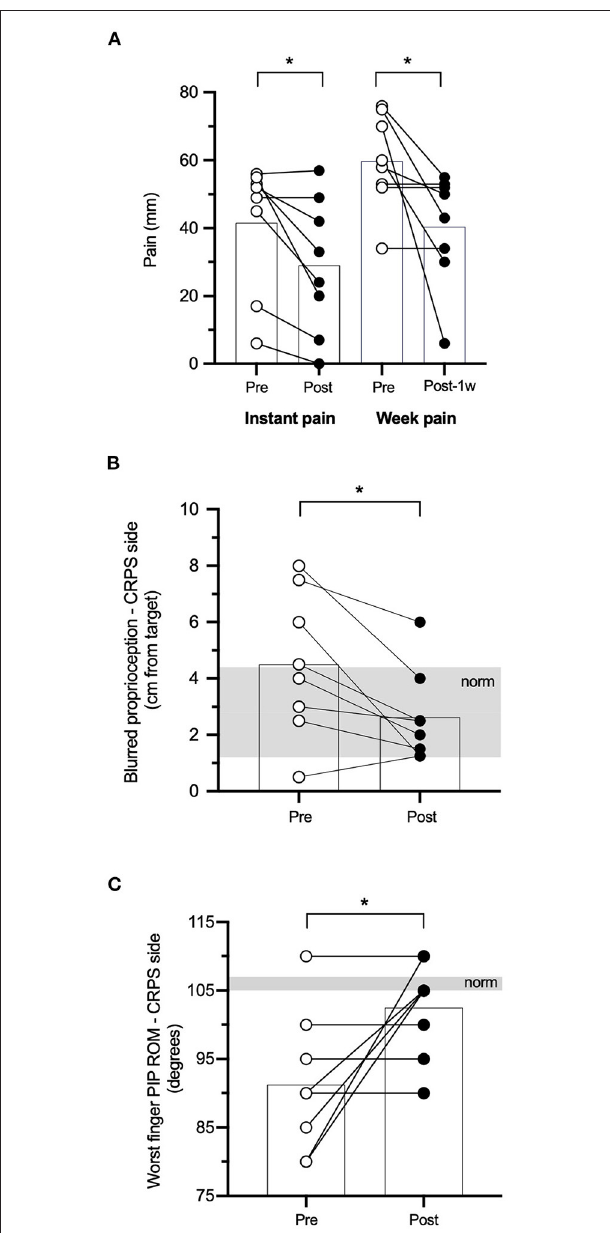
FIGURE 1 | Clinical outcomes. Individual values and group means (superimposed histograms) at pre- and post-repetitive peripheral magnetic stimulation (rPMS) (white and black circles, respectively) of instant and week pain in millimeters of a visual analog scale (VAS) (A) , blurred proprioception performance in centimeters from the target (B) , and proximal interphalangeal range of motion (PIP ROM, degrees) of the worst finger (C) . The shaded area in (B,C) represents the clinical norm (mean ± 1 SD). * p < 0.05 between pre- and post-rPMS.